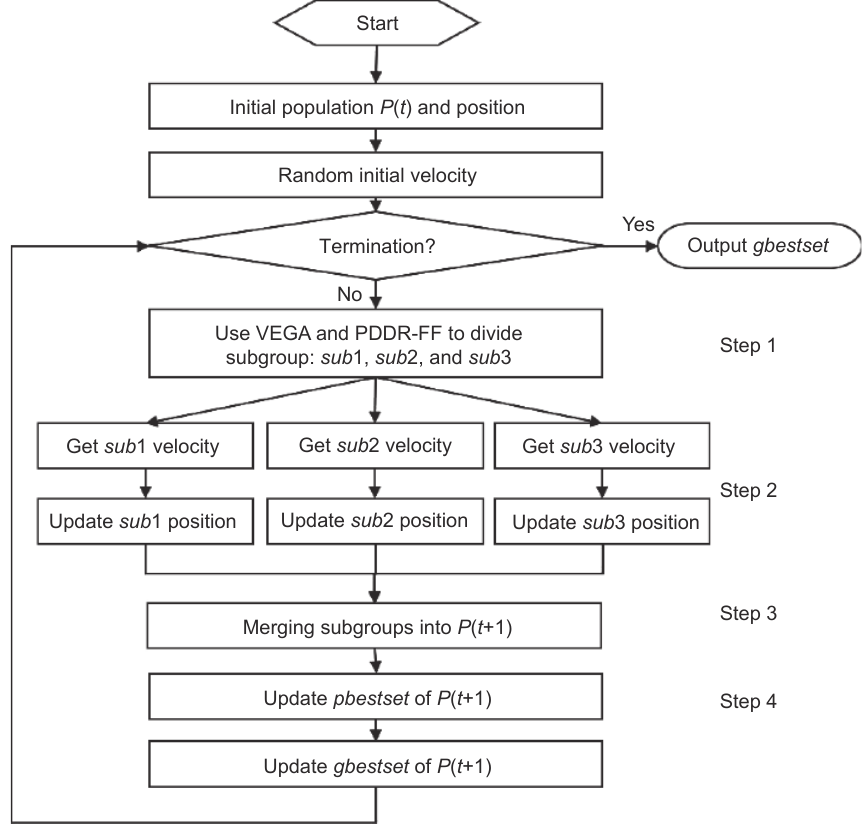
Fig. 1 Framework of